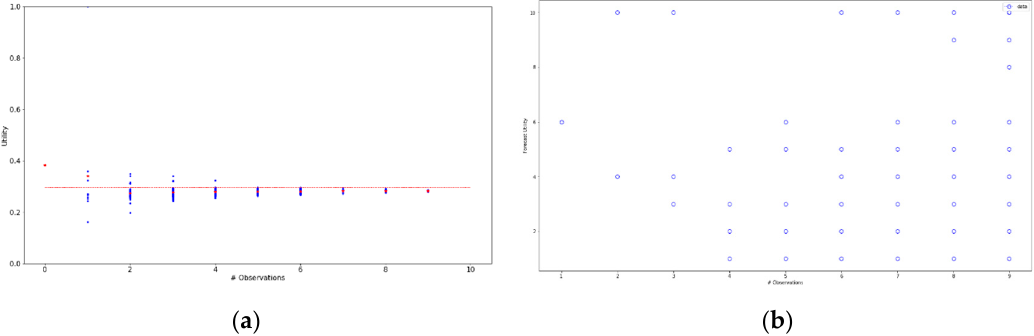
Figure 7. ( a ) Ensemble forecast utility for each observation set for one model ensemble and one selected utility level as a function of the number of observations in the set (blue point for each realization, red star for the average for each number of observations, red dashed line for the true utility); and ( b ) composition of the best set of each size for the sets in panel ( a ).